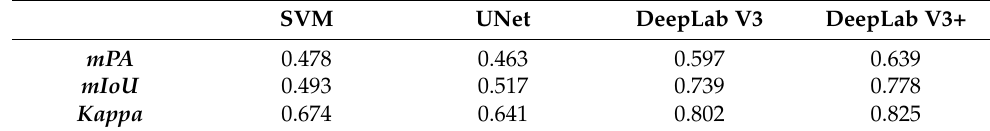
Table 4. The segmentation evaluation results of eco-environment elements.